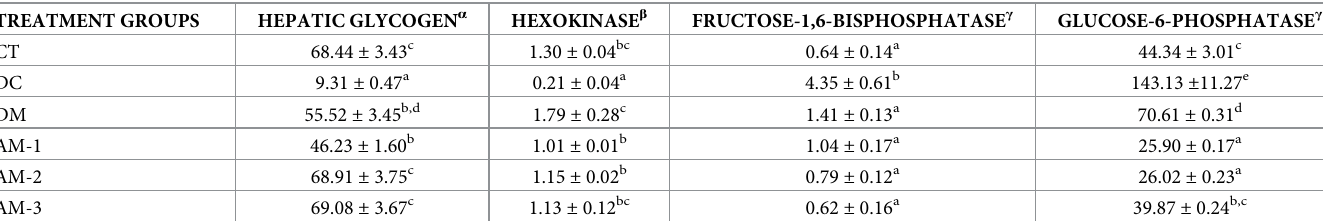
Table 9. Hepatic glycogen and carbohydrate metabolizing enzyme levels after oral administration of aqueous extract of A . muricata peels.